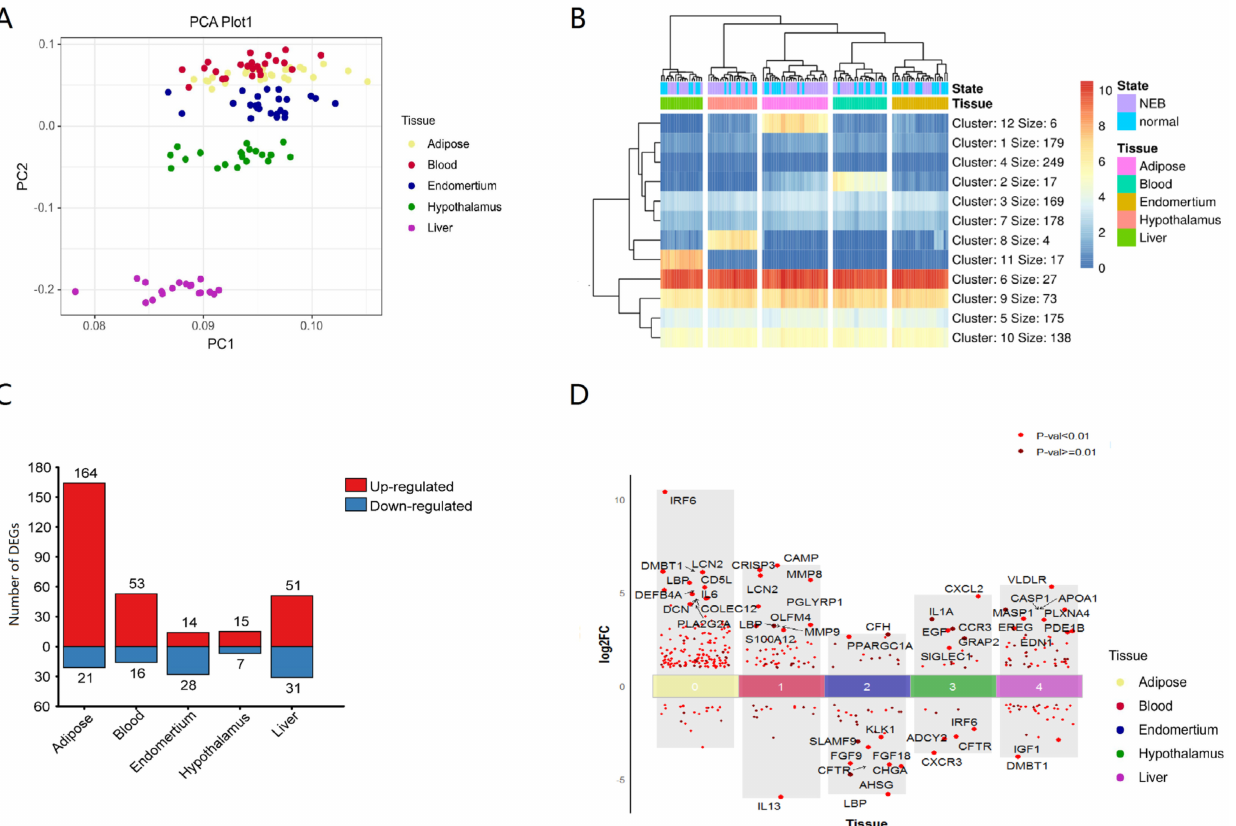
Figure 1. Transcriptional expression analysis of innate immune genes in different tissues. ( A ) PCA of 1232 bovine innate immune genes from different tissues. ( B ) Heatmap of the transcriptional expression of innate immune genes from different tissues, Kmer = 12, ( C ) DEGs (Log2FC > 1, p -value < 0.05) of innate immune genes from different tissues. ( D ) TOP 10 innate immune DEGs of different